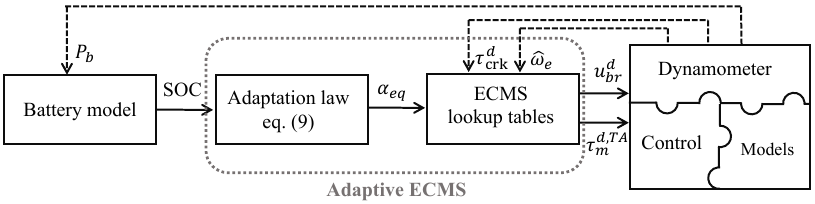
Figure 8. A-ECMS implementation for hardware-in-the-loop